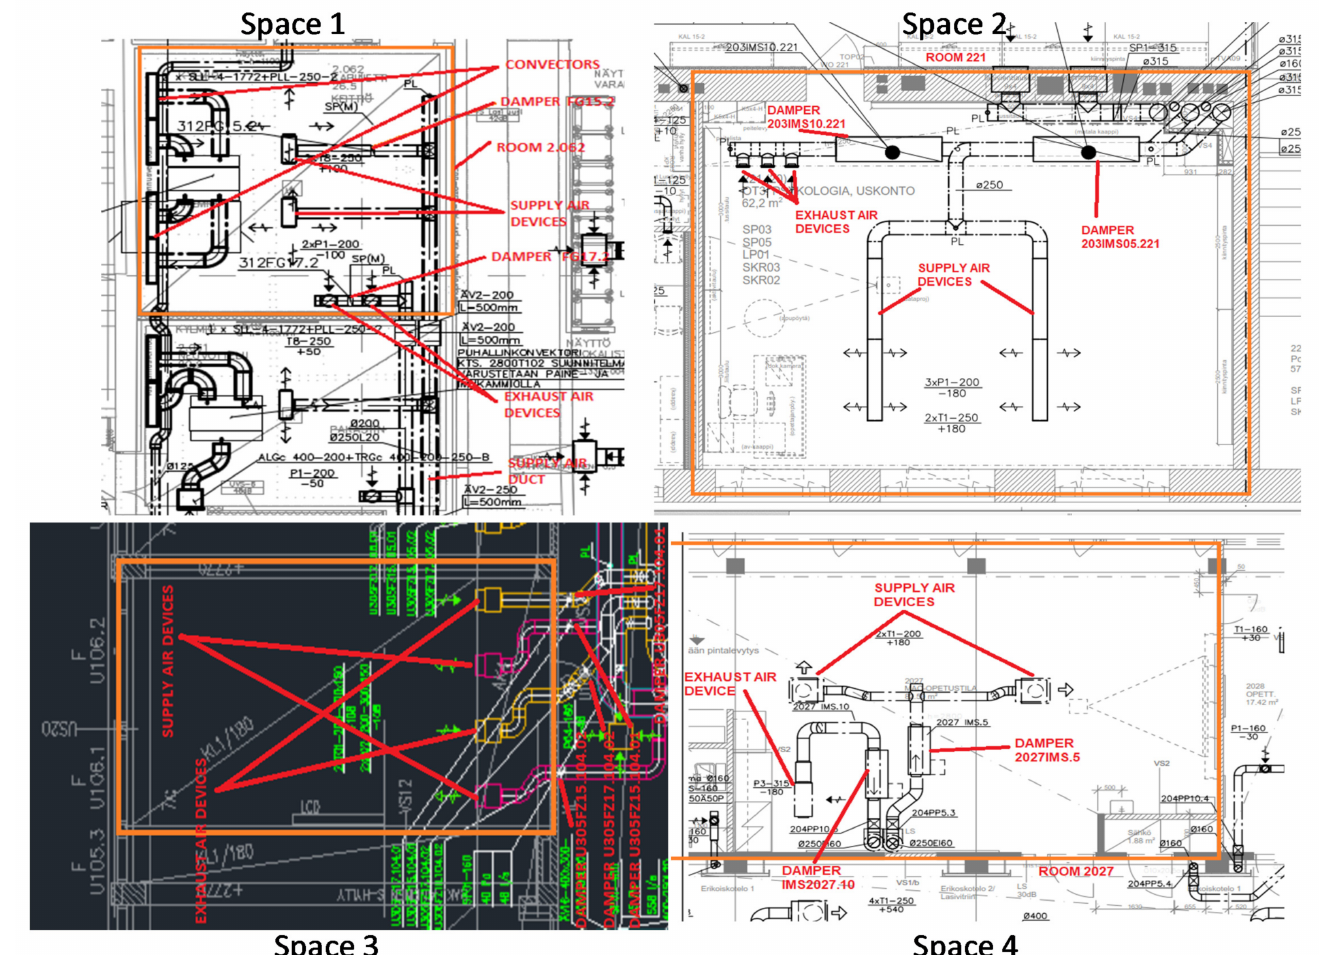
Figure 1. The drawing of ventilation systems in Spaces